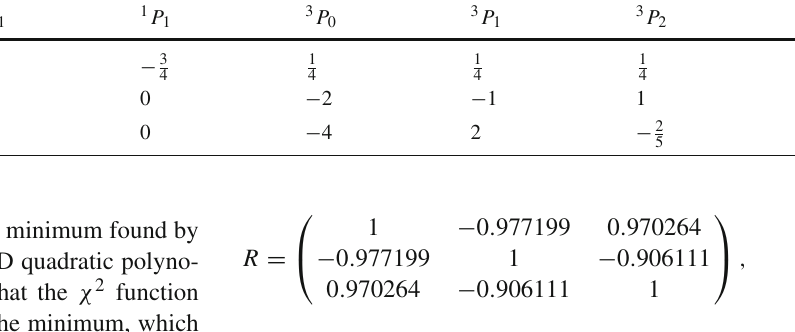
Table 1 Spin–spin, spin–orbital and tensor coefficients for the states considered in our study. Analytical expressions can be found in Eq. (15a) for the spin–spin, Eq. (15b) for the spin–orbital and Eq. (15c) for the tensor operators 1 S 3 S 0